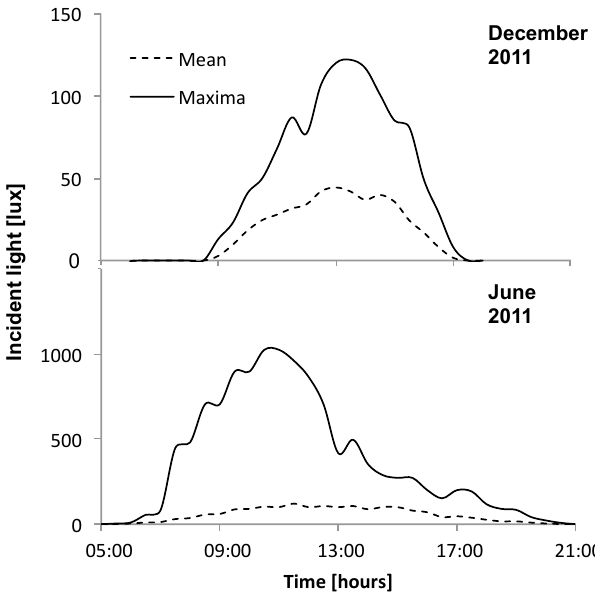
Figure 3. Summer (June) and Winter (December) daily means (dashed curve) and maxima (black curve) of half-hour-resolution light data from HOBO loggers at the Bay Bulls collection site. HOBO light sensors were oriented vertically for maximum light re-